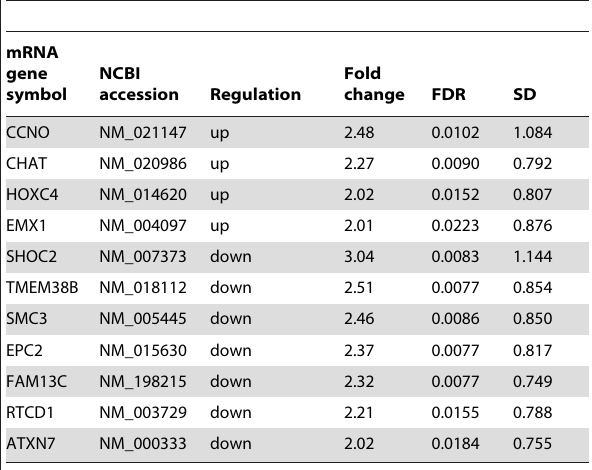
Table 6. The 11 significantly aberrantly expressed mRNAs correlated with the four validated lncRNAs.